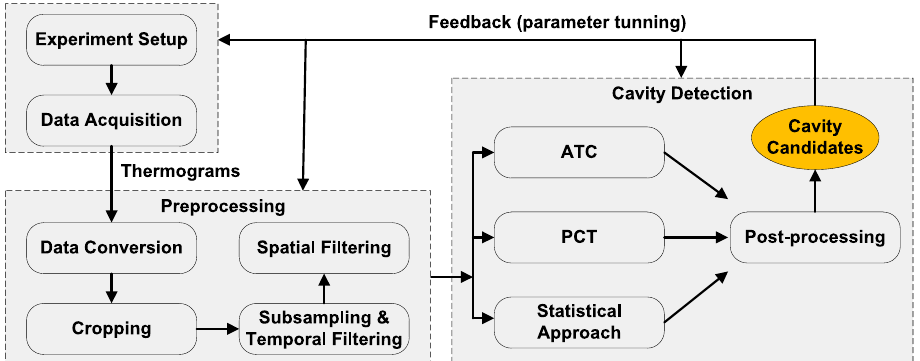
Figure 5. Processing flow. ATC: Absolute Thermal Contrast, PCT: Principal Components